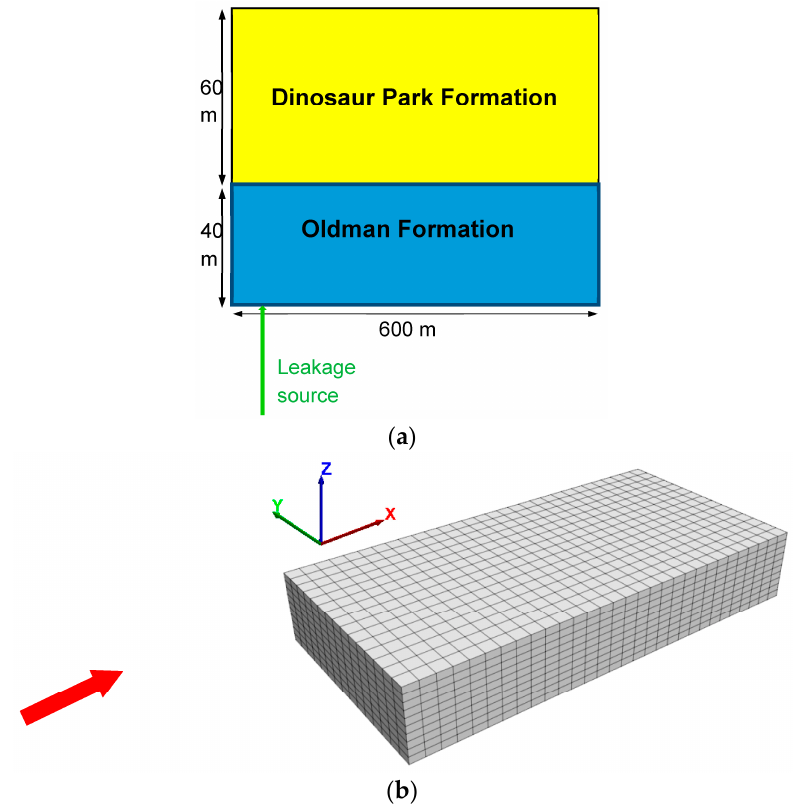
Figure 15. Schematic view of the model setup and ( a ) the FEM meshing for ( b ) modeling the consequences of CO 2 intrusion into a shallow aquifer (red arrow indicates groundwater flow direction).